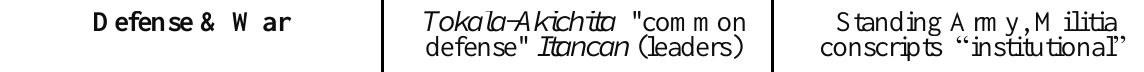
Table1C. Defense and War / Social Sphere